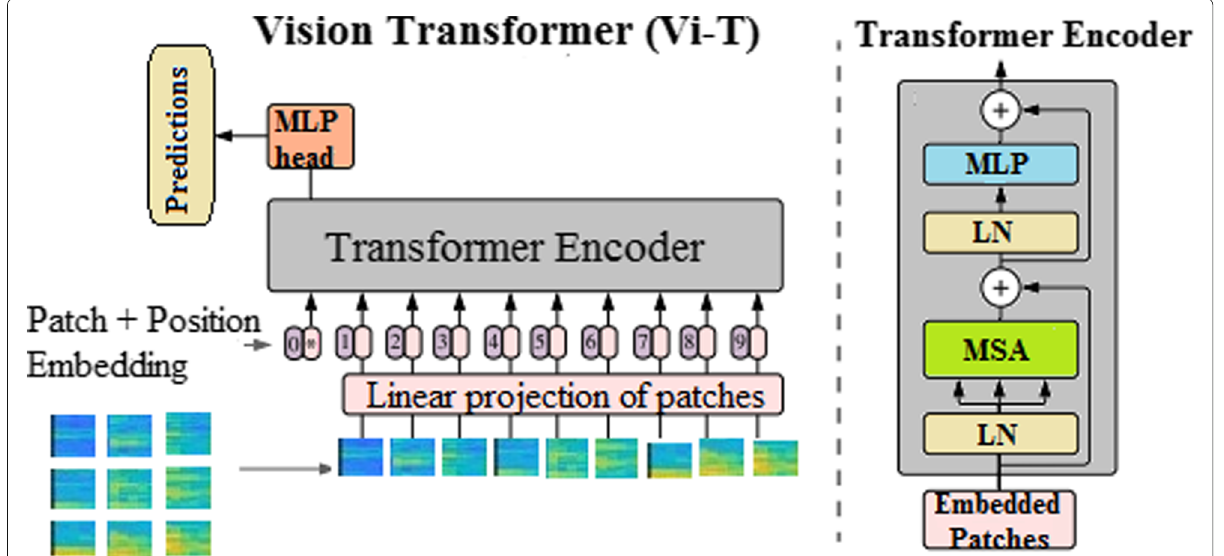
Fig. 2 (a) Block diagram of the proposed method of Vision transformer, (b) Internal architecture of transformer encoder